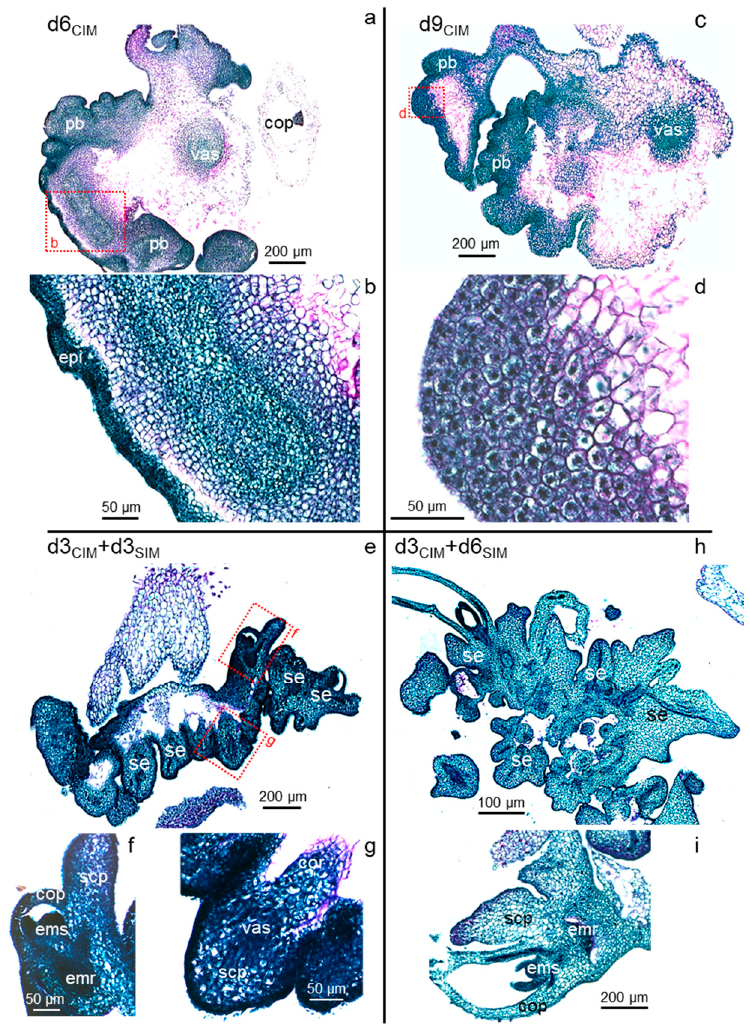
Figure 5. Morphogenesis of secondary somatic embryos. Panels show PAS-NBB-stained cross- sections of izEmb explants, after either continuous treatment with 2,4-D (d6 CIM and d9 CIM , a – d ) or a transfer to kinetin (d3 CIM + d3 SIM and d3 CIM + d6 SIM , e – i ). Explants maintained on CIM contained proliferating tissues that formed deeply invaginated lobes, in which distinct areas showed different levels of mitotic activity. Non-dividing cells lost their integrity. After transfer to SIM, multiple somatic embryos rapidly emerged in proliferating areas, each characterized by a bipolar axis delimited on either side by the shoot and root apical meristems and flanked by a scutellum. Dotted red boxes indicate close-up views of the cross-section details. cop—coleoptile; cor—coleorhiza; emr—embry- onic root; ems—embryonic shoot; epi—scutellum epidermis; pb—proliferative bulge; scp—scutel- lum parenchyma; se—somatic embryo; vas—scutellum vasculature . In d9-10 CIM explants, the invaginations expanded further and secondary bulges were readily discernible but remained attached to the primary structure (Figure 5c). Compared to earlier stages, cells in these secondary structures had doubled in size. They contained fragmented vacuoles and a central nucleus surrounded by amyloplasts, and thus ap- peared clearer and more granular (Figure 5d). These cells also accumulated additional materials in their cell walls that had deep purple coloration and marked junctions with adjacent cells. Together, these morphological changes at the cellular level are typical of the acquisition of the embryogenic fate [6,46]. A fraction of these cells, encased in thick- ened cell walls, resumed division (Figure 5d). Despite the individualization of such cell clusters and their embryogenic characteristics, SE did not occur in the explants maintained